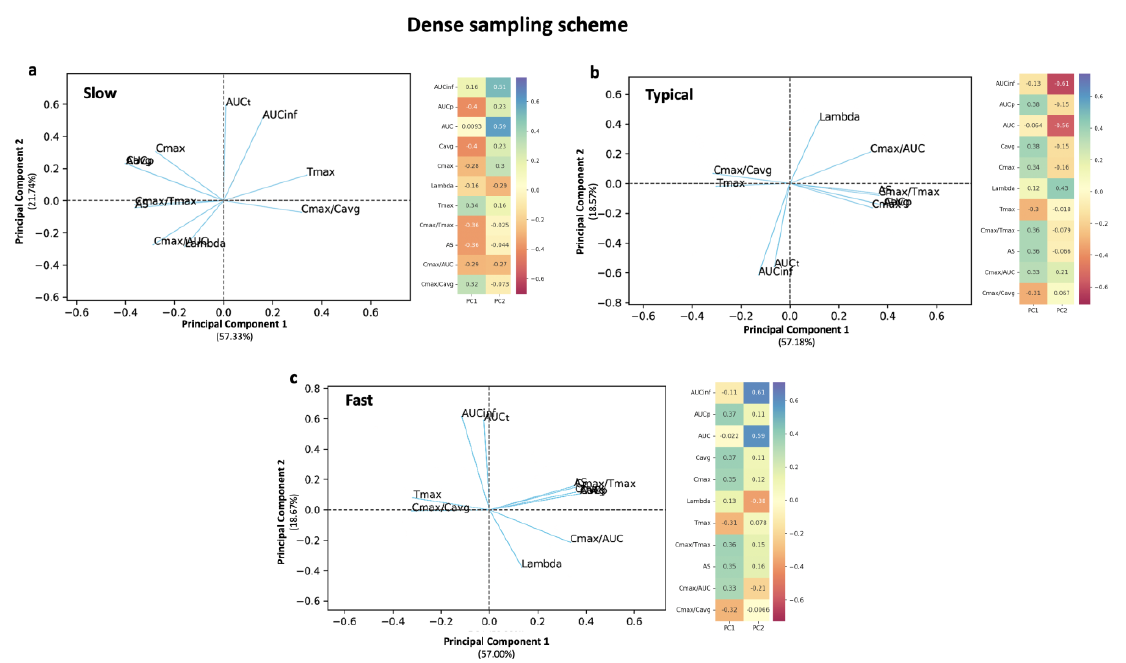
Figure A4. Principal component analysis for the pharmacokinetic parameters estimated from the simulated bioequivalence studies when a dense sampling schedule (see Table 2) was utilized. The results refer to the three simulated conditions of slow 0.5× ( a ), typical 1× ( b ), and fast 2× absorption ( c ). The terms 0.5×, 1×, and 2× refer to the number of times the absorption rate constant used in simulations is greater or less than the one observed in actual data. Left panel: Biplot of the two principal components displaying the individual scores and the loadings (blue lines). Right panel: Loading values in the case of the first and second principal components (PC1 and PC2). A description of the pharmacokinetic parameters is provided in Table 1. Table A1. Median and quartile values of the Tmax estimates. (A) The upper panel shows the median Tmax values for the calculation of partial AUC (i.e., AUCp) in the case of simulated datasets referring to slow, typical, and fast absorption. (B) The lower panel lists the Tmax quartile values of the merged datasets (i.e., when all kinds of absorption kinetics are combined) for the sparse, typical, and dense sampling schedules. The quartile values of panel “B” were used for the deployment of random forest models.